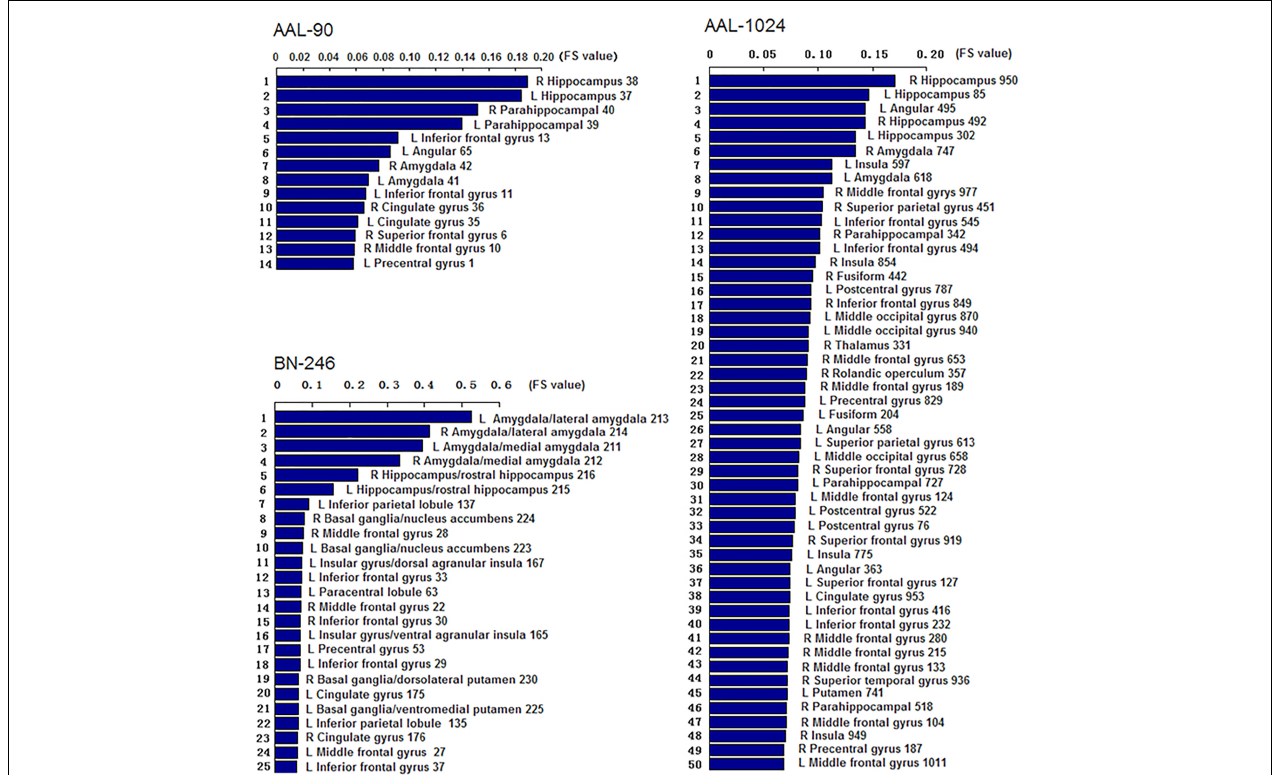
FIGURE 4 | The Fisher score values of the discriminative features in AAL-90, BN-246, and AAL-1024, respectively (The number of the discriminative features in AAL-1024 atlas was 93, and only the prior 50 features were displayed).